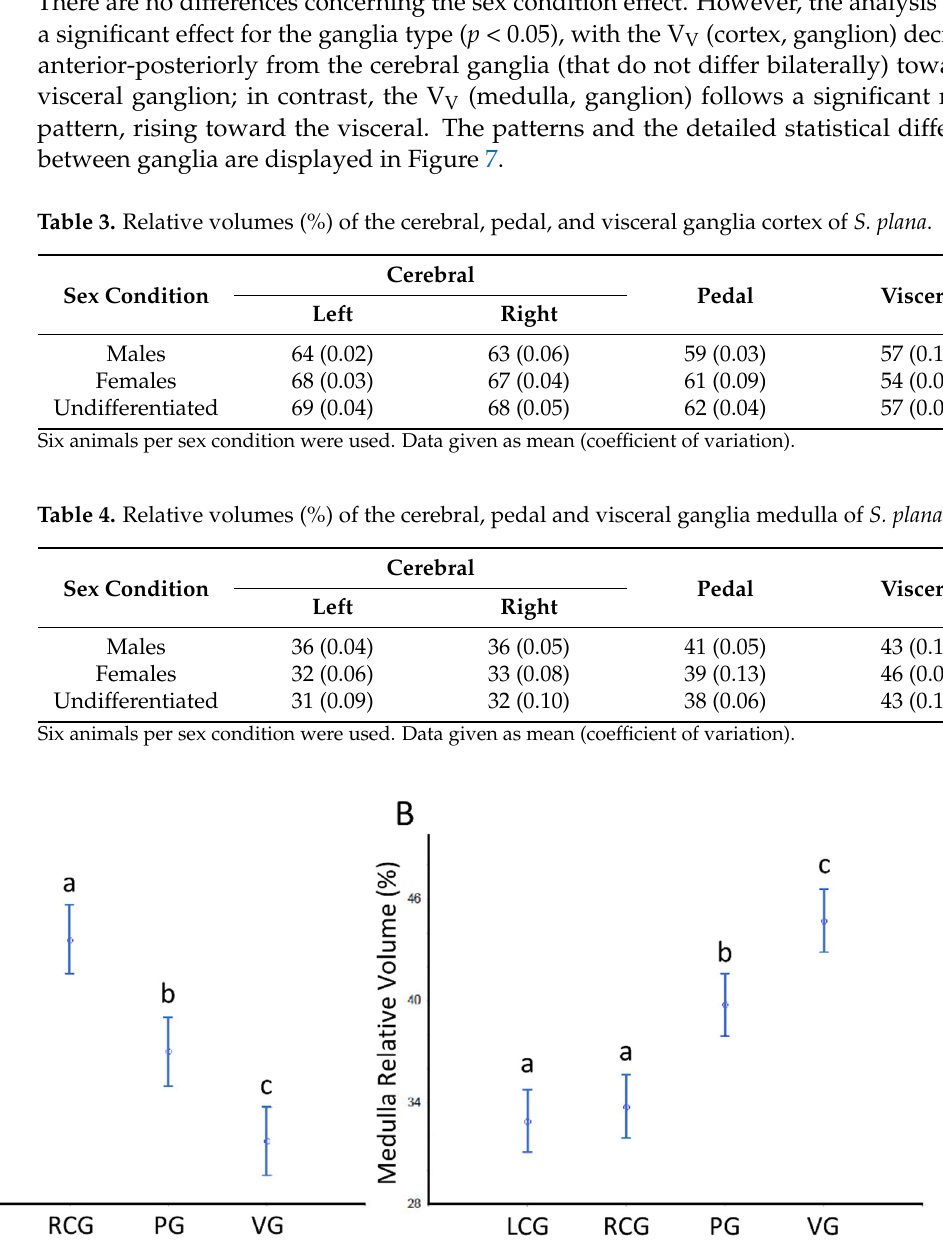
Figure 7. Relative volumes (%) of the cerebral, pedal and visceral ganglia cortex and medulla of S. plana , with all sex conditions combined. ( A ) V V (cortex, ganglion). ( B ) V V (medulla, ganglion). Different letters mean significant differences ( p < 0.05). Data as mean and 95% confidence interval. LCG: left cerebral ganglion; RCG: right cerebral ganglion; PG: pedal ganglia; VG: visceral ganglia. Six animals per sex condition were used.